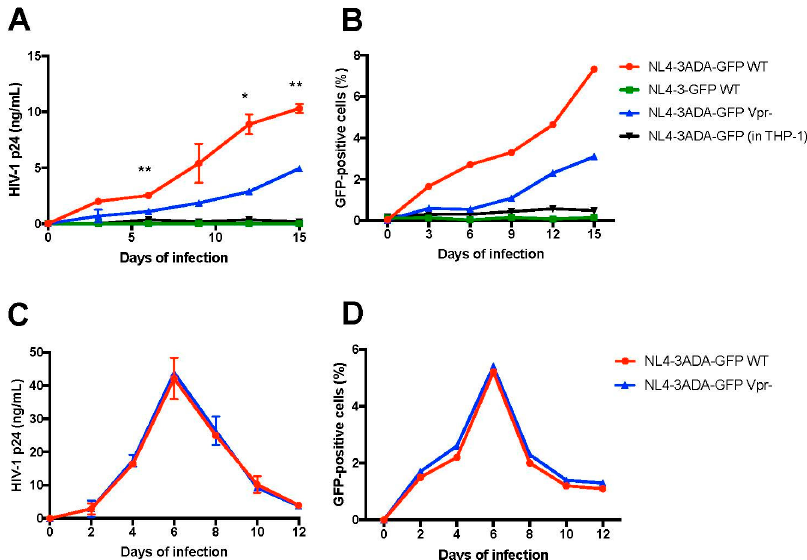
Figure 7. Differentiated THP-1-CD4 R cells sustain active HIV-1 replication and spread. * p < 0.05 and ** p < 0.01. Differentiated THP-1-CD4 R cells were infected (MOI = 5) with either WT (Vpr+) or Vpr-negative (Vpr − ) NL4-3ADA-GFP virus (CCR5-tropic) virus, or NL4-3-GFP virus (CXCR4-tropic) and the levels of HIV-1 p24 in the supernatant ( A ) and GFP-positive cells ( B ) measured over time. Differentiated THP-1 cells were infected with WT (Vpr+) virus as controls. Alternatively, CD4+ T cells were infected with the same viral stocks (MOI = 0.1); HIV-1 p24 in the supernatant ( C ) and GFP expression ( D ) were assessed over time. For HIV-1 p24, the mean p24 levels ± SD ( n = 2) are shown and compared using Student’s t test at selected time points. WT and Vpr − viruses showed no significant difference in kinetics in CD4+ T cells.